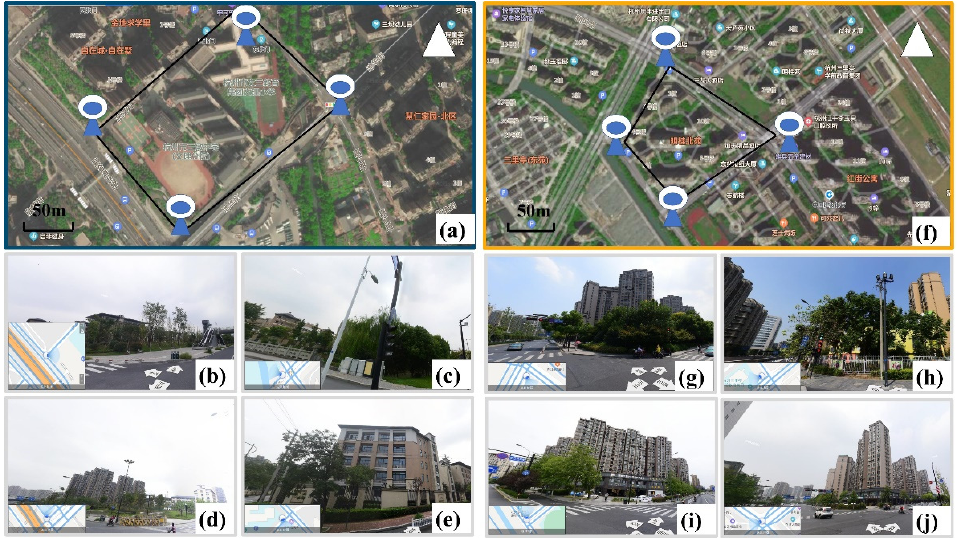
Figure 4. Illustration of the institution and residence parcels in Baidu map and Baidu street view: ( a ) represents the institution parcel in Baidu map; ( b – e ) represent the four perspectives of institution parcel in Baidu street view; ( f ) represents the residence parcel in Baidu map; and ( g – j ) represent the four perspectives of residence parcel in Baidu street view. The Chinese labels for ( a ) and ( f ) represent the name of POIs.